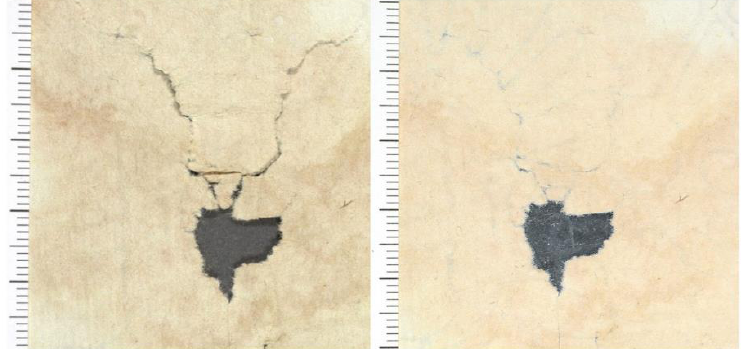
Figure 9. Cracks and leakage of damaged paper before treatment ( left ). After a direct application of nanocellulose, the cracks are closed ( right ) and the damaged paper is consolidated and stabilized. Reproduced under terms of the CC-BY license [89]. Copyright © 2017, The Authors, published by Springer Nature.